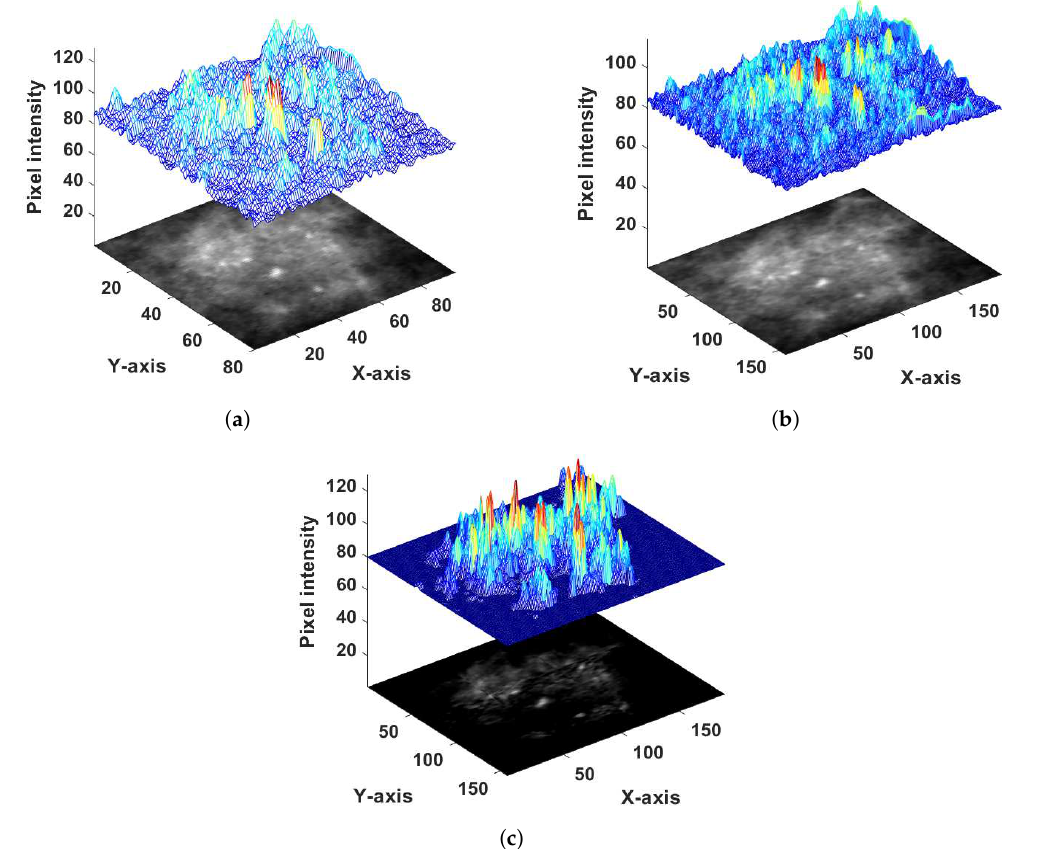
Figure 4. ( a ) Three-dimensional intensity representation of a 158 × 189 pixel area of a digital mammogram; ( b ) calculated object background intensity of the same area; and ( c ) the difference image between the original image ( a ) and the background image ( b